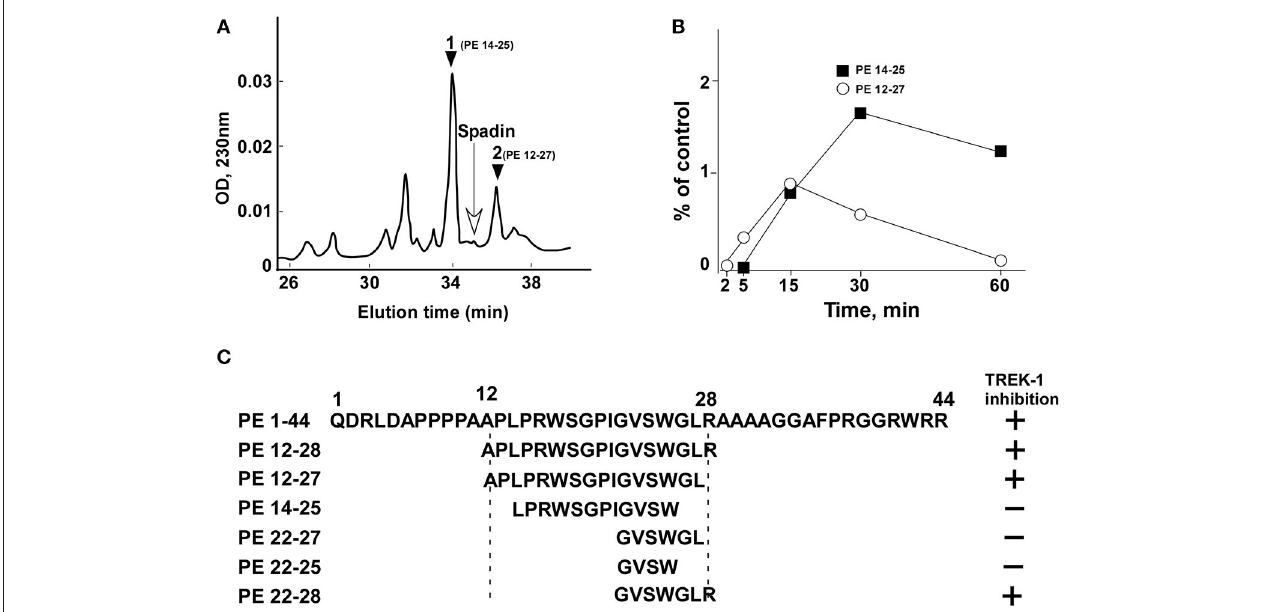
FIGURE 1 | HPLC profiles of spadin degradation products in serum. (A) A typical HPLC profile obtained after 30 min incubation of spadin with mouse serum at 37 ◦ C. The position of spadin peak is indicated by an arrow. (B) Kinetics of appearance of peaks 1 (PE 14-28) and 2 (PE 12-27). (C) Sequences of shortened peptides and their capacity to inhibit TREK-1 activity compared with PE and spadin (PE 12-28)